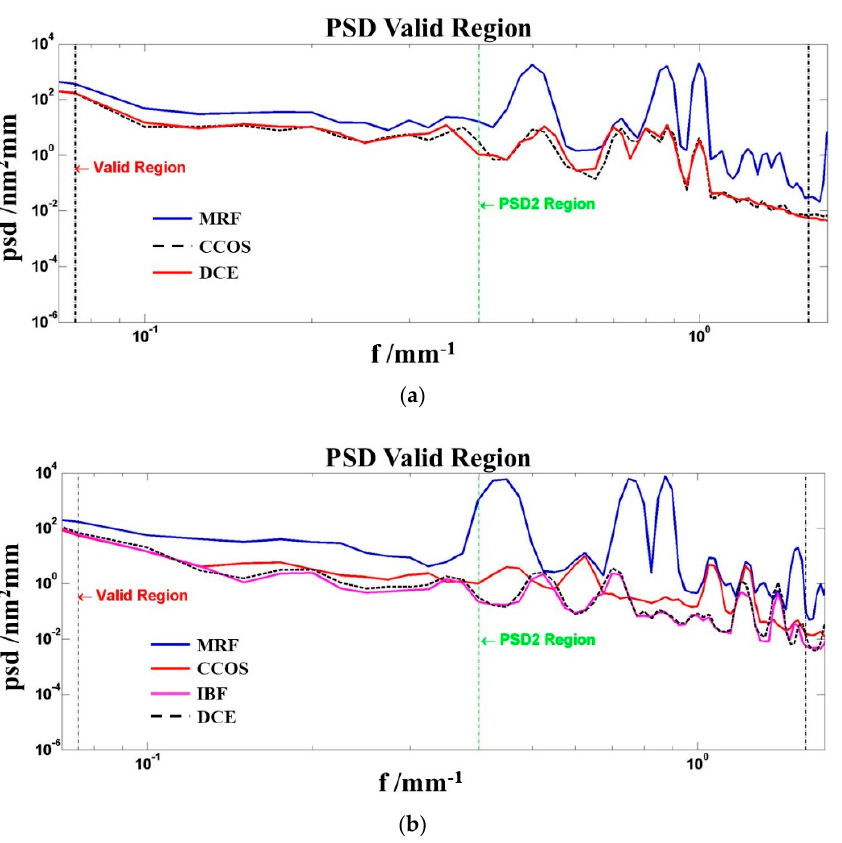
Figure 1. Power spectral density (PSD) results of samples: ( a ) 3–PSD information; ( b ) 4–PSD information.